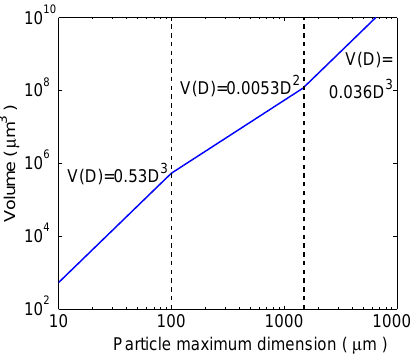
Figure 6. Relationship between ice crystal volume and maximum